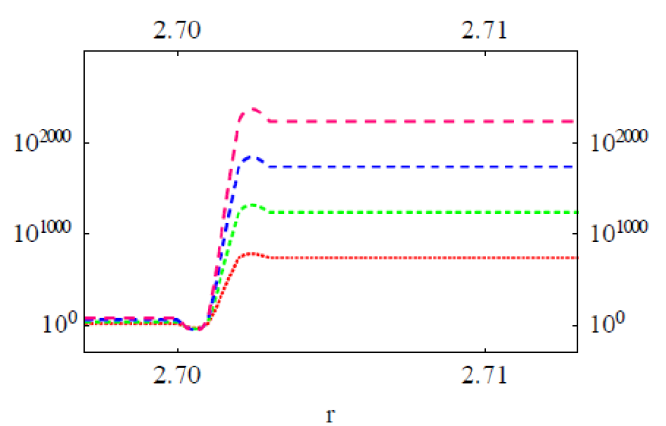
Figure 9. Numerically computed scale free energy versus reaction coordinate r plots of Equation (1). Col in Col cluster (top panel) and Col in lipid (e.g., PC) cluster (bottom panel). In both panel figures there are 4 curves representing energies of four SCI orders first, second, third, fourth (bottom to top). Here a = 1 nm, q Col q PC = 10 − 2 e 2 , as PC is nearly charge neutral, but MAAs are negatively charged in physiological aqueous phase (see [44]). e is the electron charge.